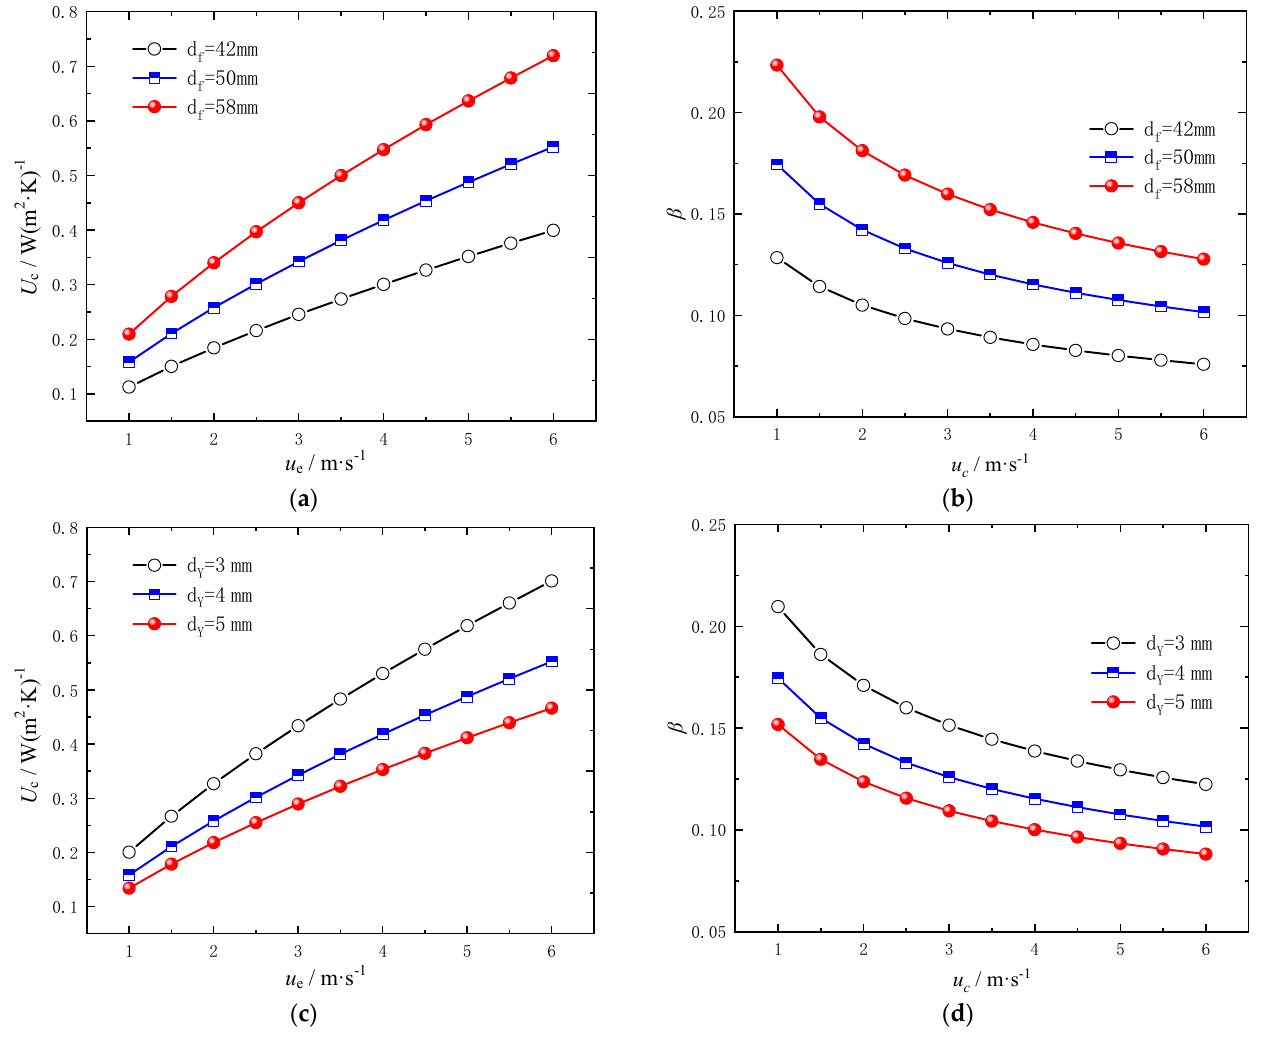
Figure 5. The effect of different fin parameters and cross-section wind speed on dimensionless coefficient, β , and heat transfer coefficient under dry conditions: ( a ) the effect of cross-section wind speeds and d f on the heat transfer coefficient; ( b ) the effect of cross-section wind speeds and d f on the dimensionless factor, β ; ( c ) the effect of cross-section wind speeds and d Y on the heat transfer coefficient; ( d ) the effect of cross-section wind speeds and d Y on dimensionless factor, β .